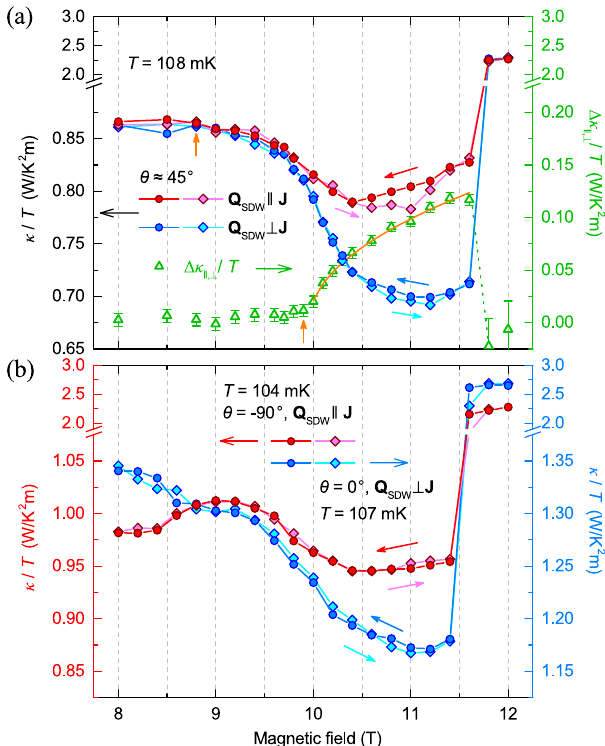
FIG. 3. (a) Magnetic-field dependence of the thermal conduc- tivity over T ( κ =T ) in and around the Q phase. The field directions are the same as in Fig. 2. The data for field sweeps down (circles) and up (diamonds) are shown. The difference ( Δ κ ∥ ; ⊥ =T ) for the two orientations of Q (green triangles, right axis) starts to grow ffiffiffiffiffiffiffiffiffiffiffiffiffiffiffiffiffiffiffiffiffiffiffiffiffiffiffi p SDW ð H − H Þ =H above 9.9 T and is well described by the fit c c shown (orange curve). Weak hysteresis within the Q phase is likely due to a vortex-lattice transition for H ∥ ½ 100 (cid:2) at μ 0 H ≈ 11 T, observed recently with scanning tunneling microscopy [33]. ∥ J (red symbols), and θ ¼ 0 ° (b) κ =T for θ ¼ − 90 ° when Q SDW ⊥ J (blue symbols). The data are very similar to those when Q SDW for the same relative orientation of Q and J , correspondingly SDW colored, in (a). The scales of the y axes in (a) and (b) are the same but with different offsets. The features for both θ ¼ − 90 ° and θ ¼ 0 ° between 8 and 9 tesla are likely due to a vortex-lattice transition for H ∥ ½ 110 (cid:2) between 7.5 and 8.7 T